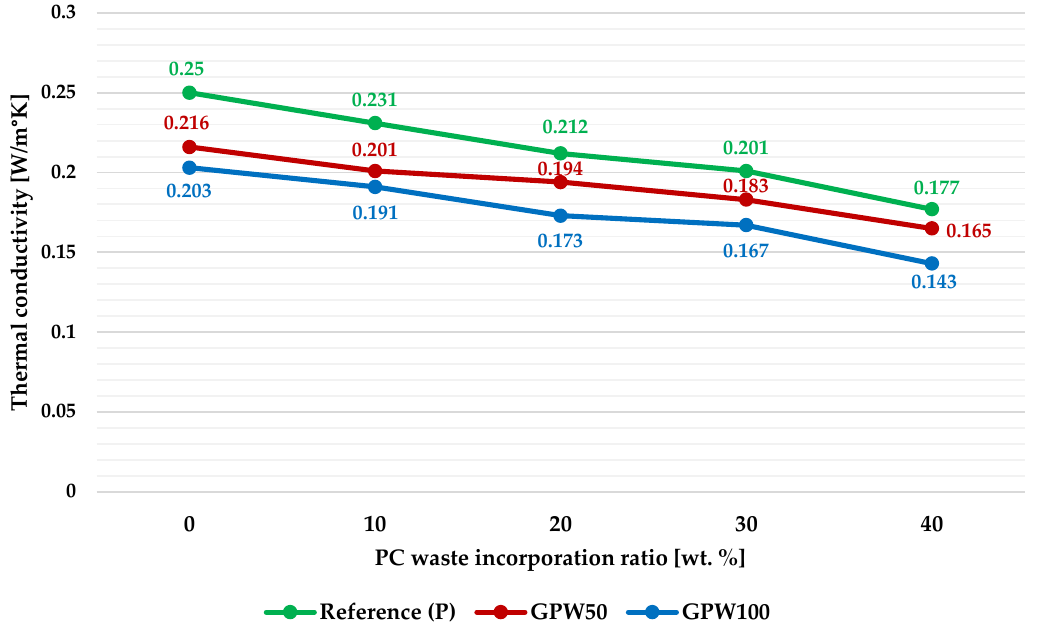
Figure 7. Thermal conductivity of the developed gypsum plasters.